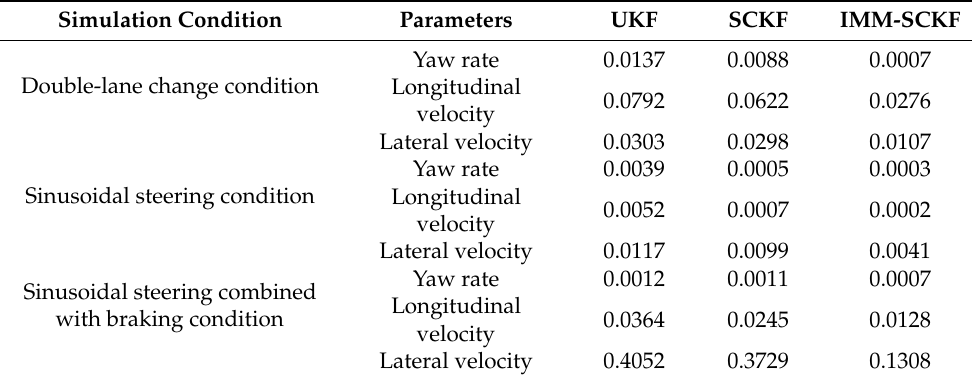
Table 2. Comparison of RMSE values under two simulation conditions. Simulation Condition Parameters UKF SCKF IMM-SCKF Yaw rate Double-lane change condition